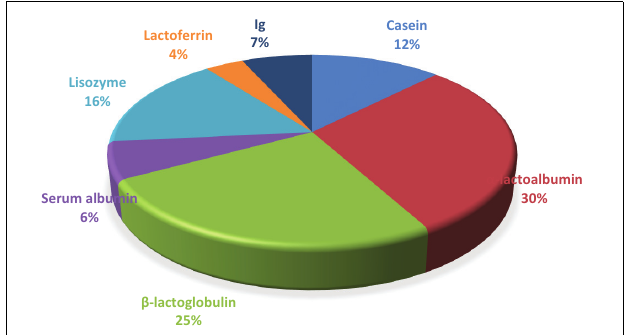
FIGURE 1 | Distribution of donkey milk proteins analysed by polyacrylamide electrophoresis expressed as a percentage with respect to total proteins ( n = 12).